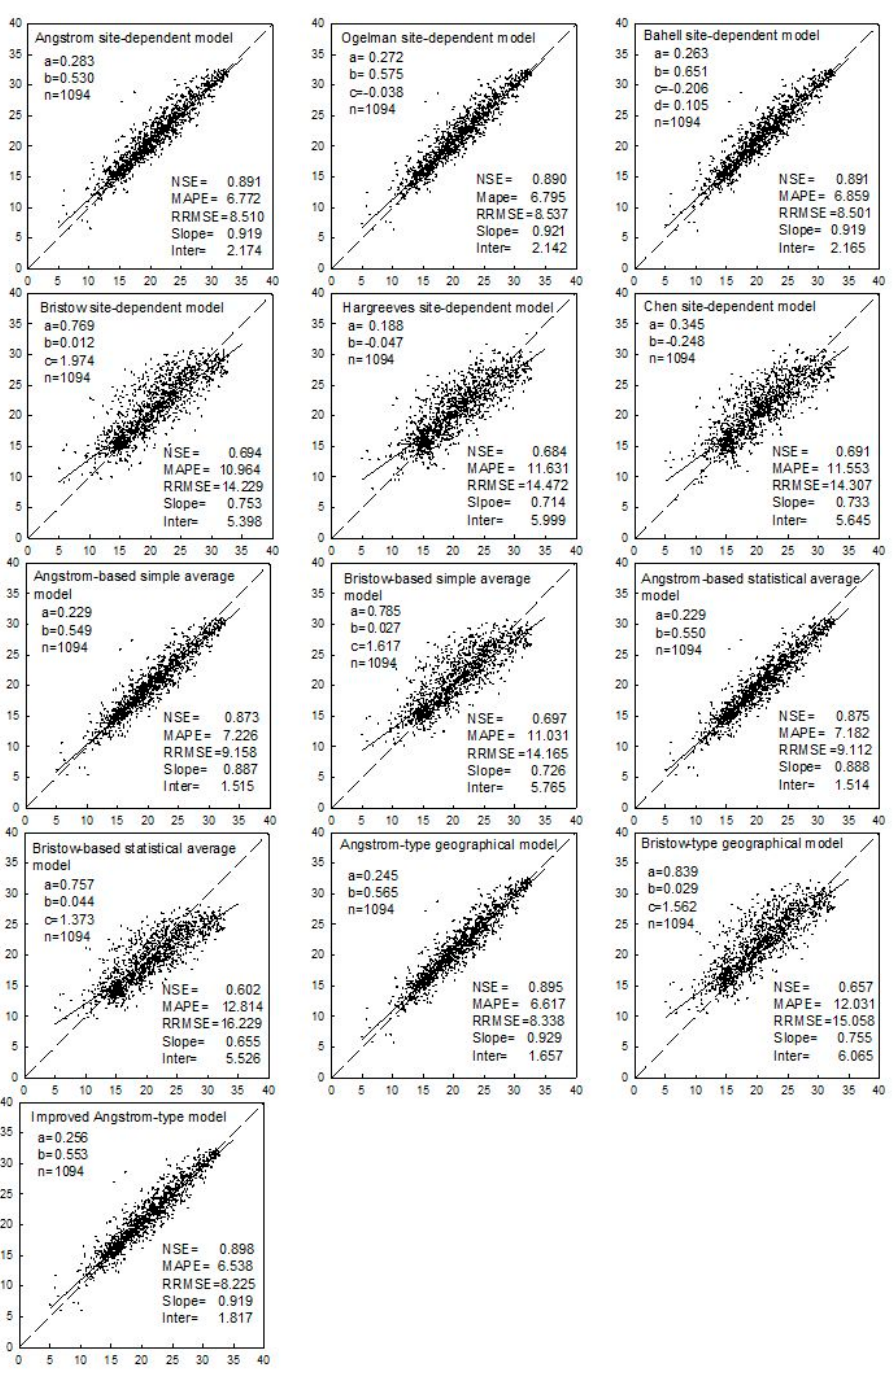
Figure 5. Performance of different models in predicting daily solar irradiation in Lhasa from 2008 to 2010. The horizontal axis denotes observation values, and the vertical axis prediction values (unit: MJ·m − 2 ).